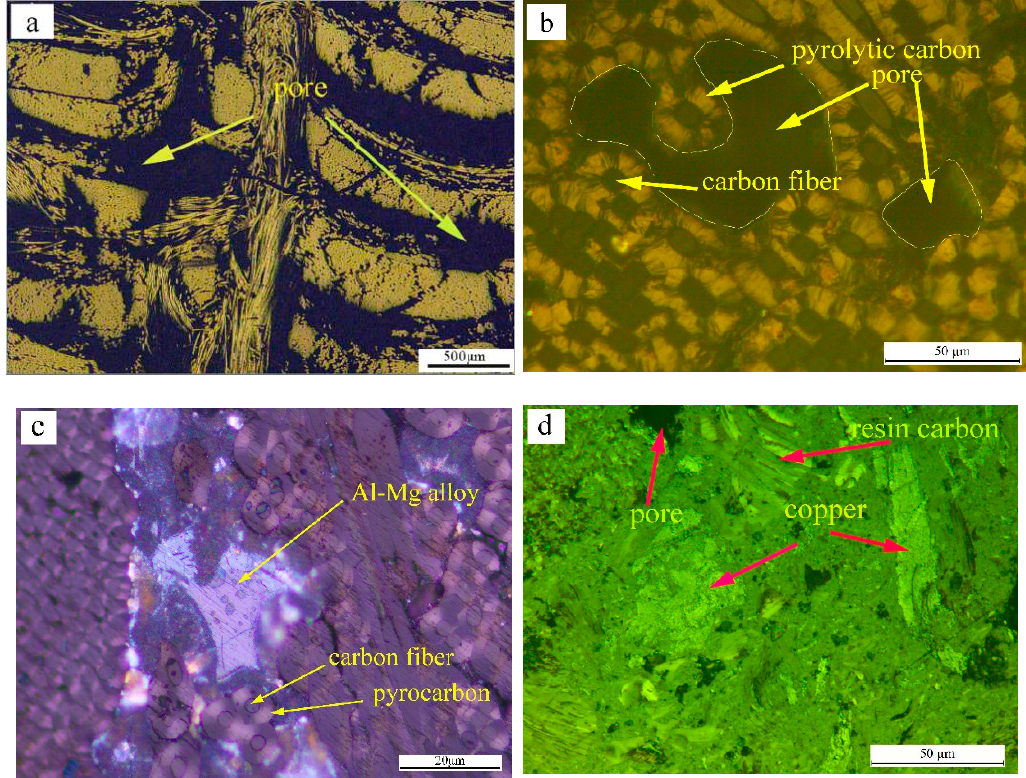
Figure 3. Polarization morphology of carbon/carbon (C/C) composites and optical micrographs of aluminum–magnesium alloys of C/C composites. ( a ) Initial polarization morphology of C/C; ( b ) Optical micrograph of C/C ( X – Y direction) viewed with a polarizing microscope; ( c ) Optical micrograph of C/C–Al–Mg ( X – Y direction); ( d ) Optical micrograph of the steeped metal slider.